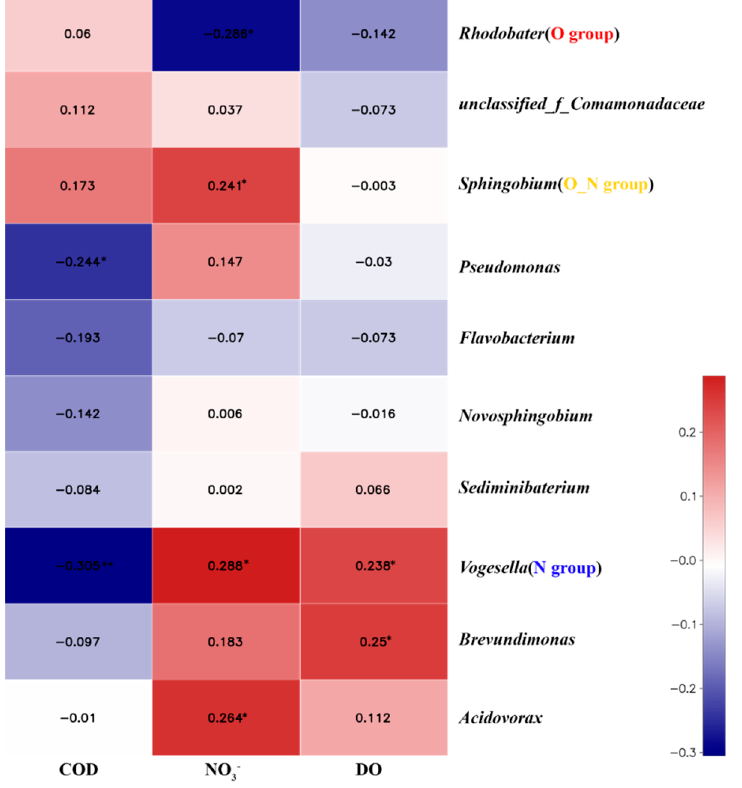
Figure 9. Heatmap plot for the first 10 dominant genera. Numbers in the table are the R value, the right legend is the color interval of different R values. A p -value of more than 0.01 and less than 0.05 is marked as the superscript of numbers with an *.